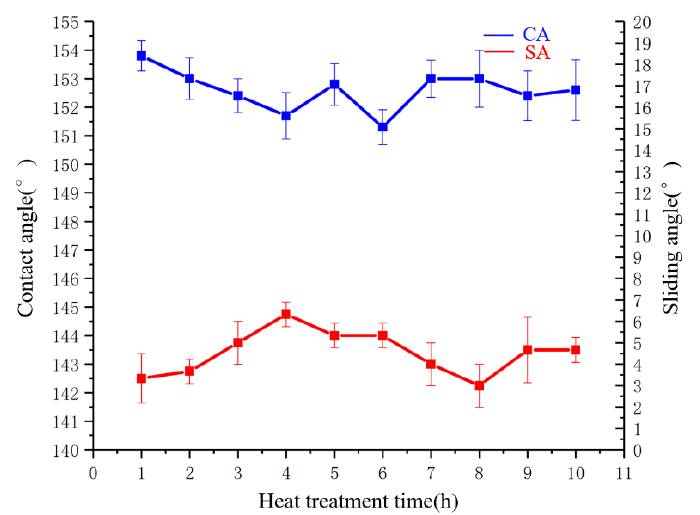
Figure 16. CA and SA corresponding to different treatment durations at 300 °C.